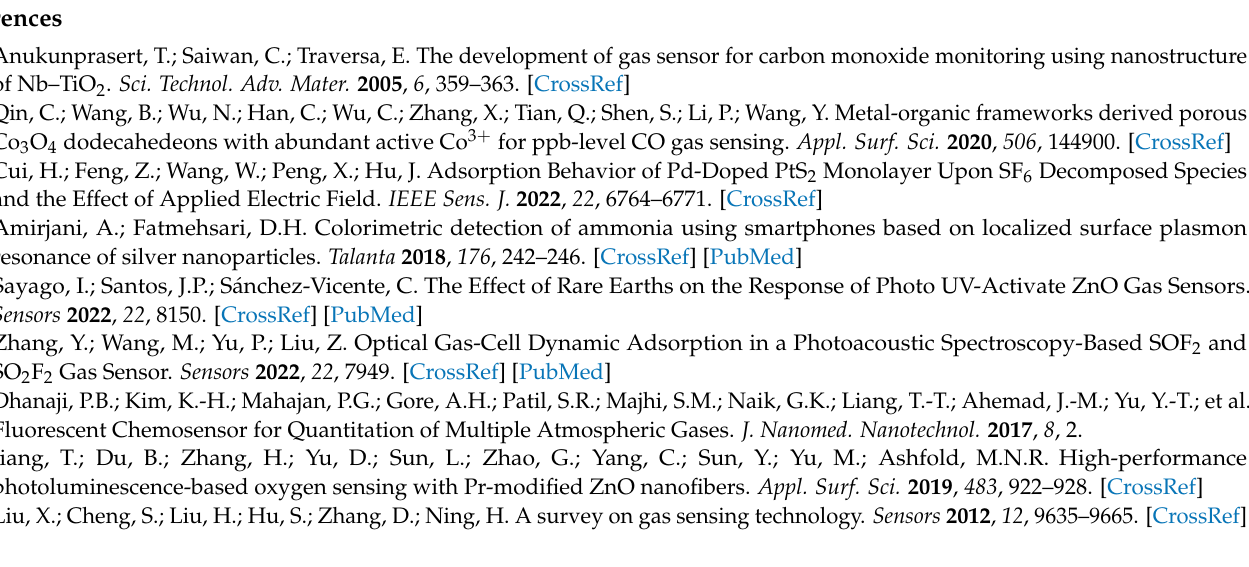
Figure S4: Particle size distributions of (a) as-synthesized NCs, (b) Olac-25, (c) Olac-50 and (d) Olam 25; Figure S5: Change in emission intensity of (a) as-synthesized CPB NCs, (b) Olac 25, (c) Olac 50, and (d) Olam 25 samples at different O 2 concentrations; Figure S6: TEM images of (a) Agg-1, (b) Agg-2, and (c) Agg-3 samples; Figure S7: Sensitivity of Agg-1 sample at different O 2 concentra- tions; Figure S8: Photostability of CPB NCs fabricated on the AAO membrane filter; Table S1: The response and recovery behaviors of all the devices, and the response and recovery